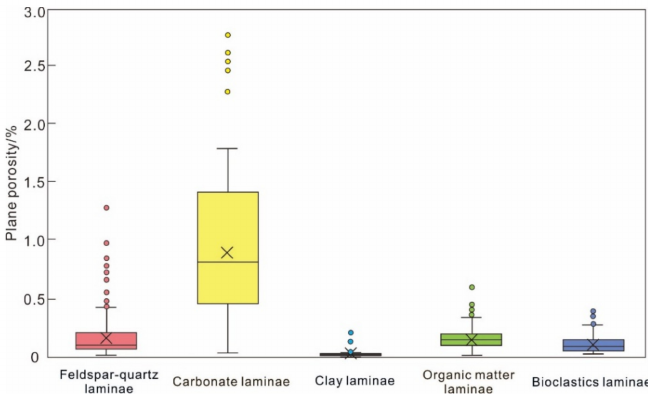
Figure 11. Box plot of thin section porosity in different laminae.